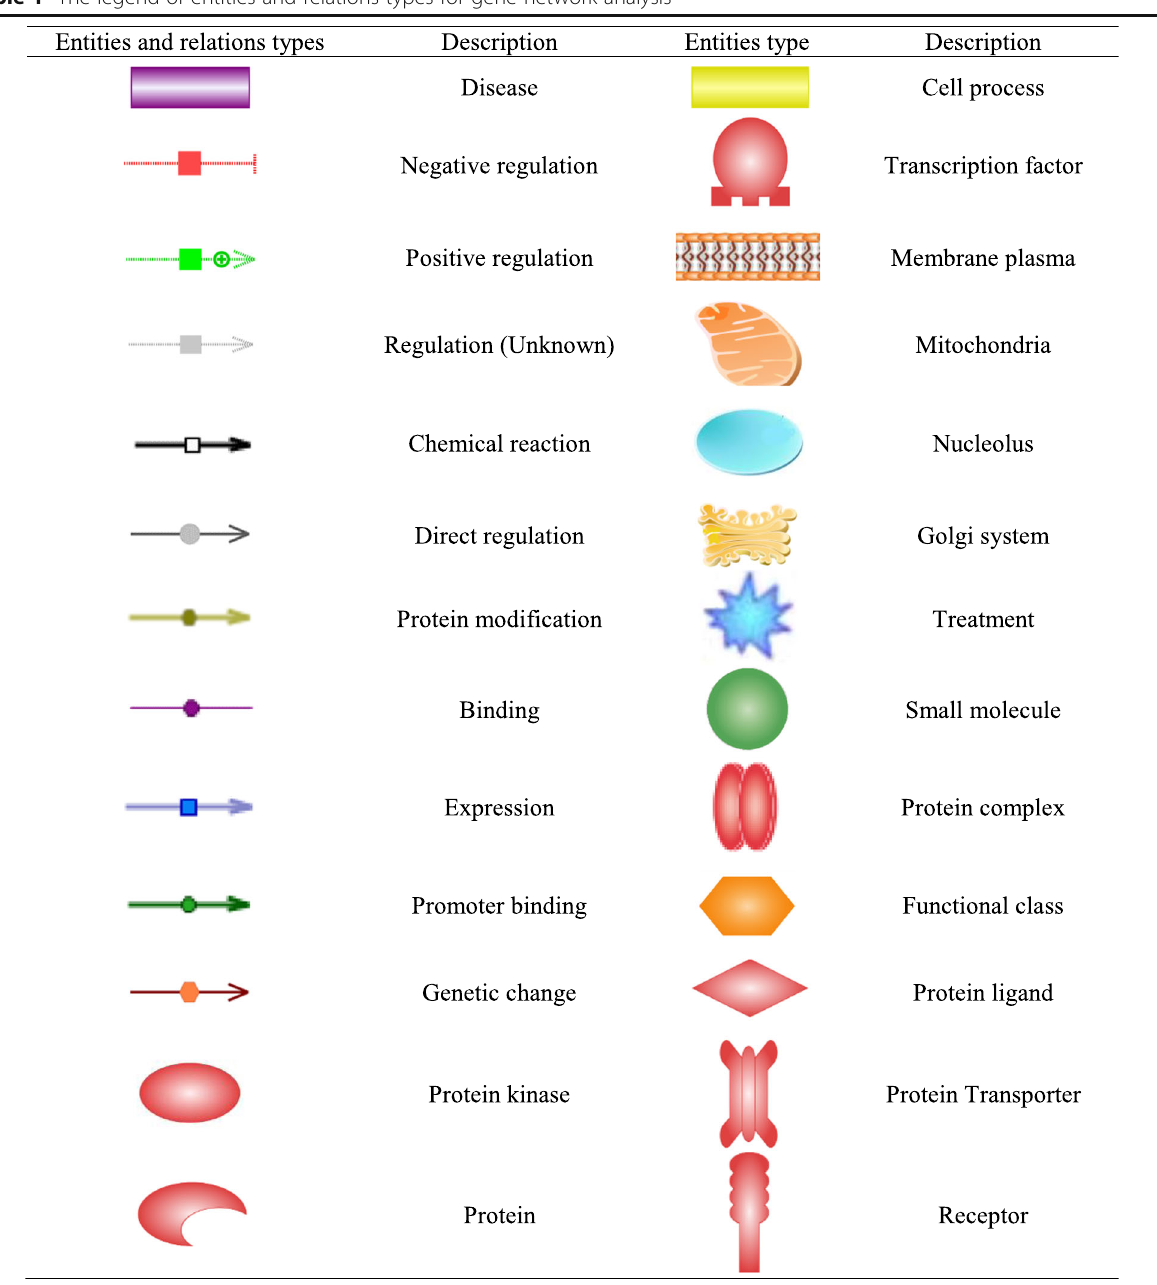
Table 1 The legend of entities and relations types for gene network